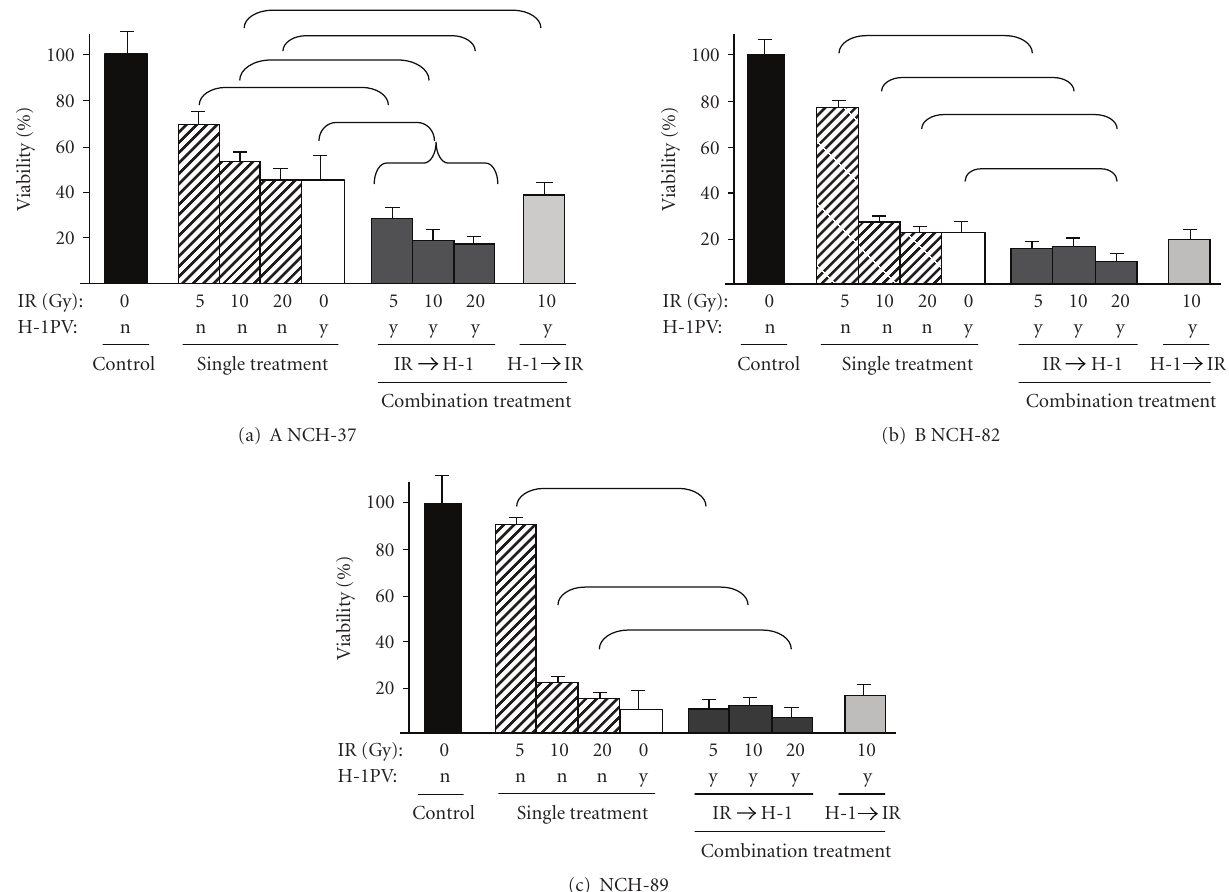
Figure 2: E ff ects of ionizing radiation (IR), parvovirus H-1 (H-1PV) infection, and combination of IR and H-1PV infection on human high- grade glioma cells. Short-term cultures of human gliosarcoma NCH-37 (a), human glioblastoma NCH-82 (b), and human glioblastoma NCH-89 (c) were seeded at 30,000 cells/well, irradiated with 5Gy, 10Gy, or 20Gy, and infected with H-1PV at an MOI of 5 PFU/cell 24 hours post-IR (IR → H-1) or cells were infected with H-1PV at an MOI of 5 PFU/cell and irradiated with 10 Gy 24 hours post-infection (H- 1 → IR). E ff ects on cell survival were compared to single treatment with IR or single treatment with H-1PV. Control cells were mock-infected and transported to the accelerator but not exposed to IR (0Gy). All experiments were performed in three independent assays. Viability (%) was assessed as the number of living treated cells over the number of living untreated cells three days post (mock-) infection. Error bars represent the respective standard error. Significant di ff erences ( P < . 05) between single treatment and combination treatment groups are indicated by